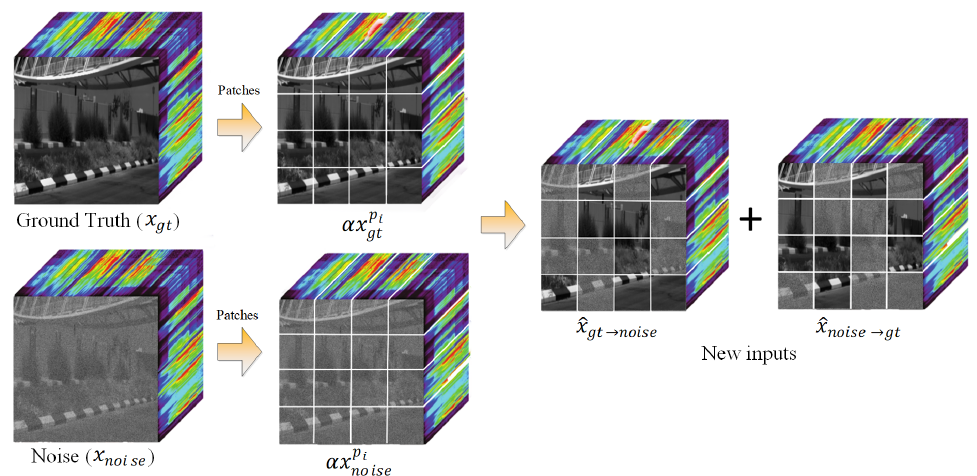
Figure 1. The whole operation process of PatchMask.